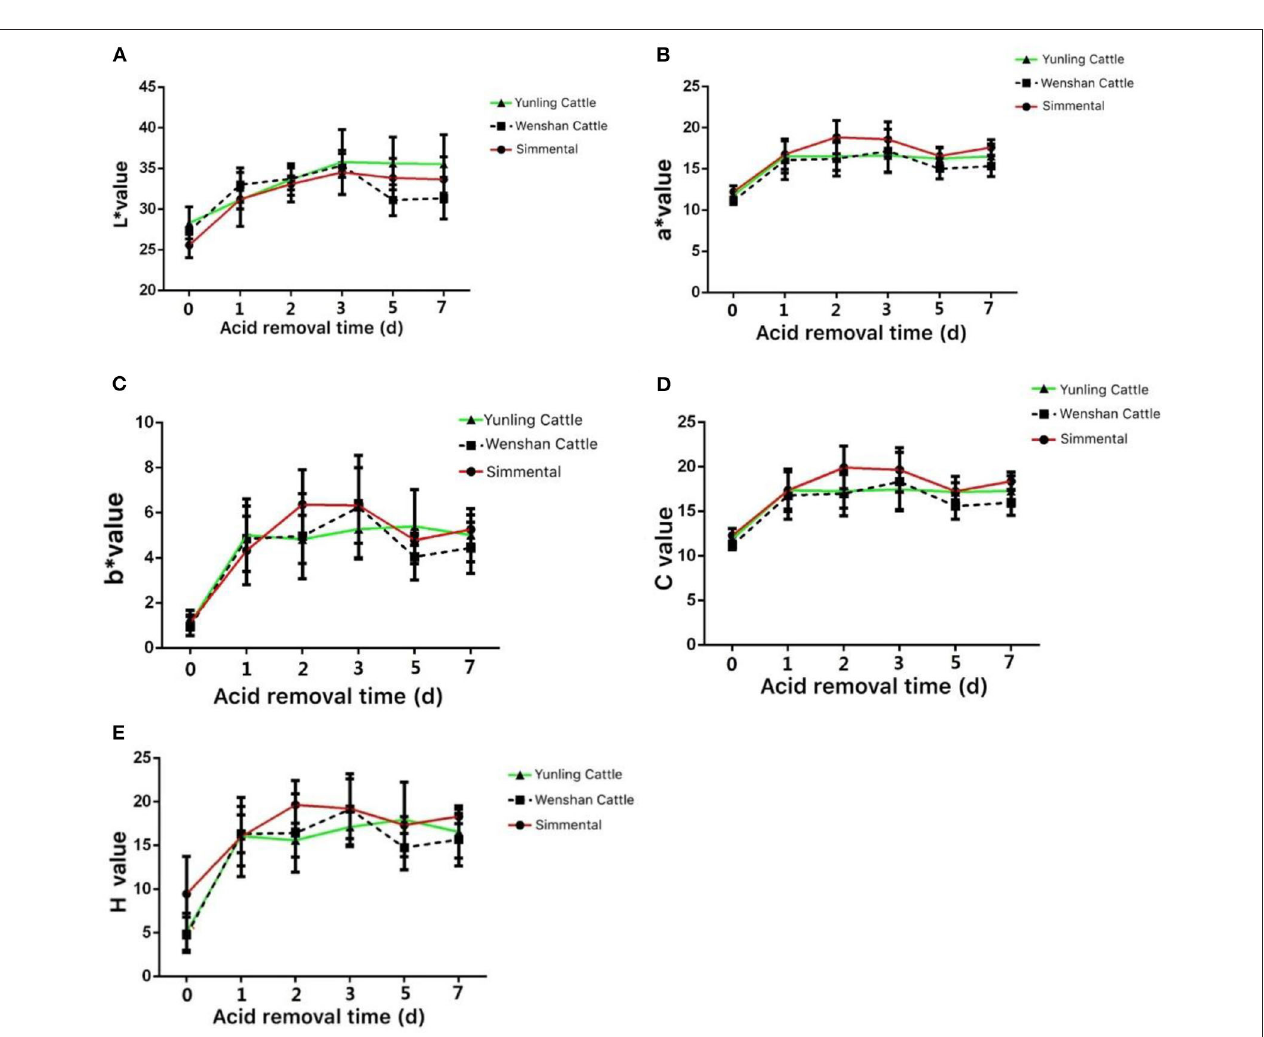
FIGURE 2 | Meat color at different growth periods in the three cattle breeds. (A) Change in the L * value in the muscle aging process of the three cattle breeds; (B) change in the a * value during muscle aging in the three cattle breeds; (C) change in the b * value during muscle aging in the three cattle breeds; (D) change in the c * value during muscle aging in the three cattle breeds; (E) change in the H value during muscle aging in the three cattle breeds. Data were presented as means ± SD of at least three independent experiments.